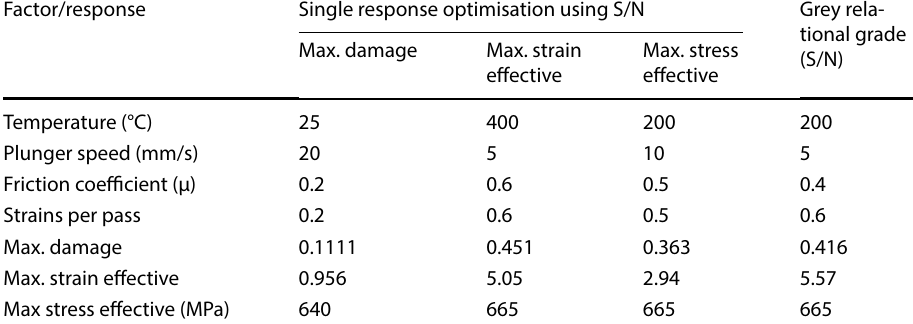
Table 9 Optimum conditions for the MDF process and their output